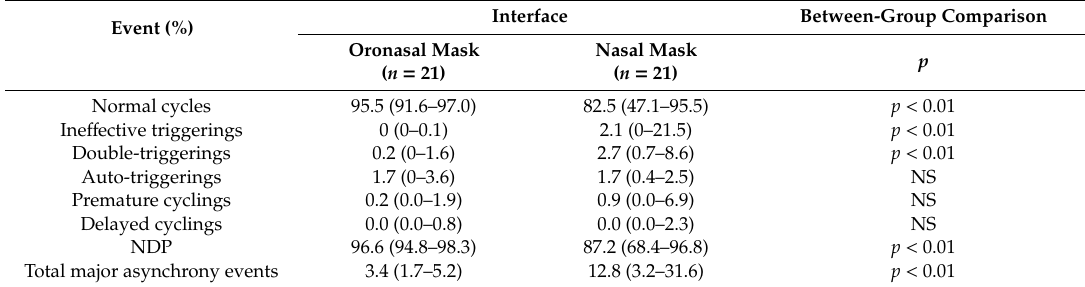
Table 2. Asynchrony index according to the interface.